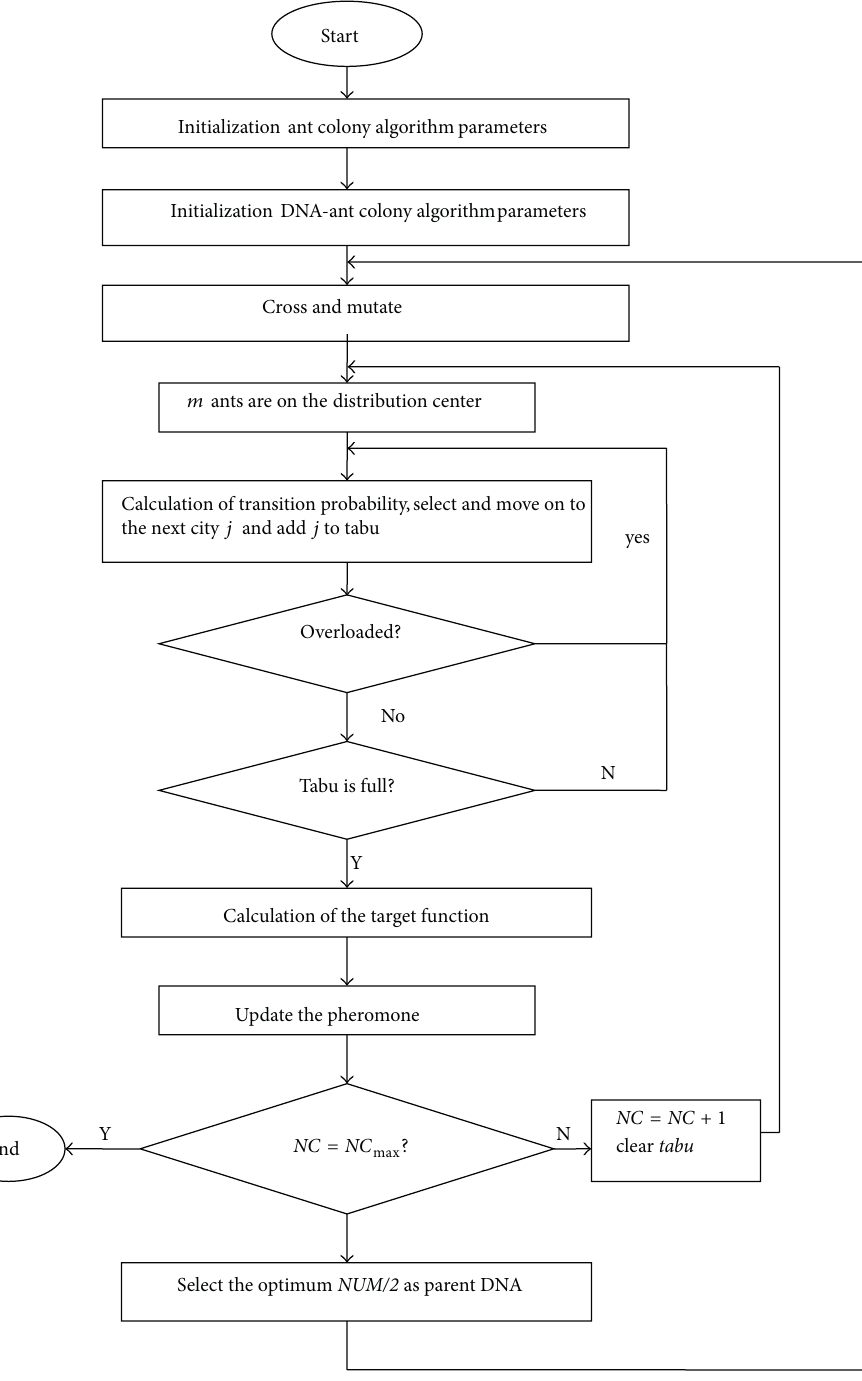
Figure 1: The model solution flow chart of DNA-ant colony